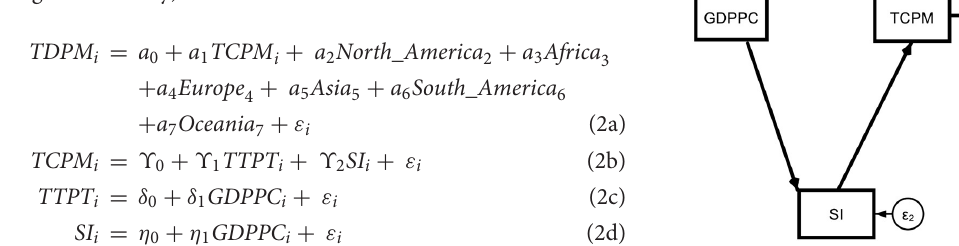
Model 1a. Theoretical path models (base model with regional dummy).